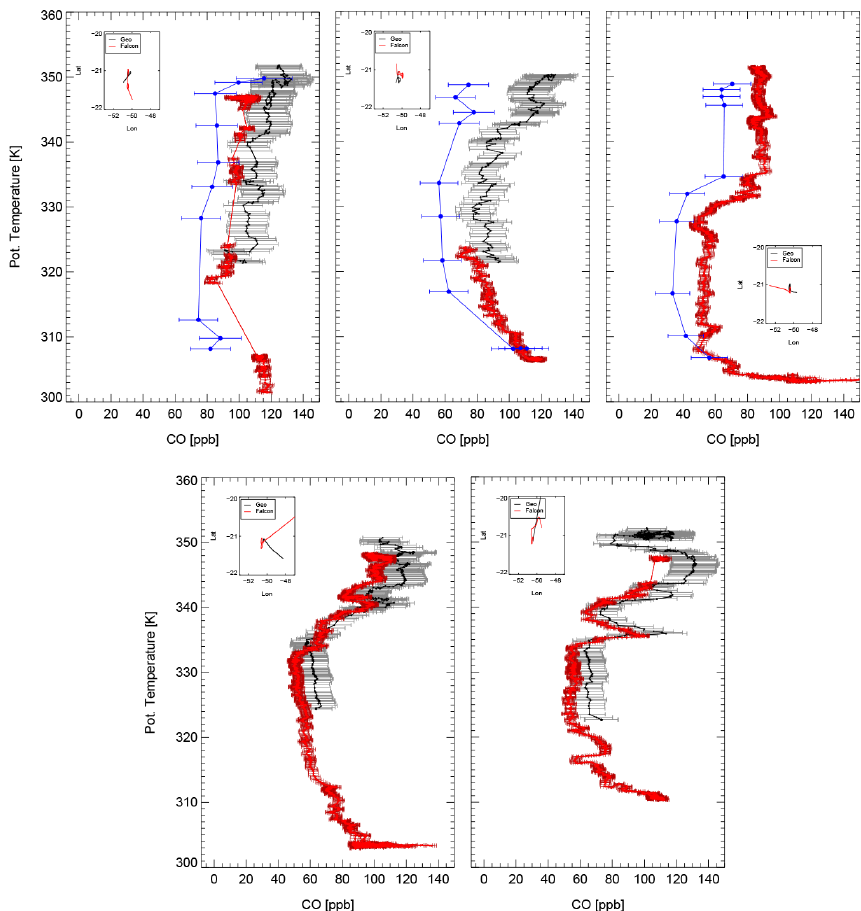
Figure A3. Comparison of CO measurements during descent by the COLD instrument aboard the Geophysica (black) and CO measurements aboard the Falcon (red) (see Table A1 for the exact time period, which is compared). If available, data from HAGAR aboard the Geophysica are shown in blue. Shown are data for 4 February 2005 (top left), 5 February 2005 (top middle), 8 February 2005 (top right), 15 February 2005 (bottom left) 18 February 2005 (bottom right). Total measurement uncertainty (determined as the square root of the sum of squares of the accuracy and precision of the measurements) is shown as uncertainty range for COLD and